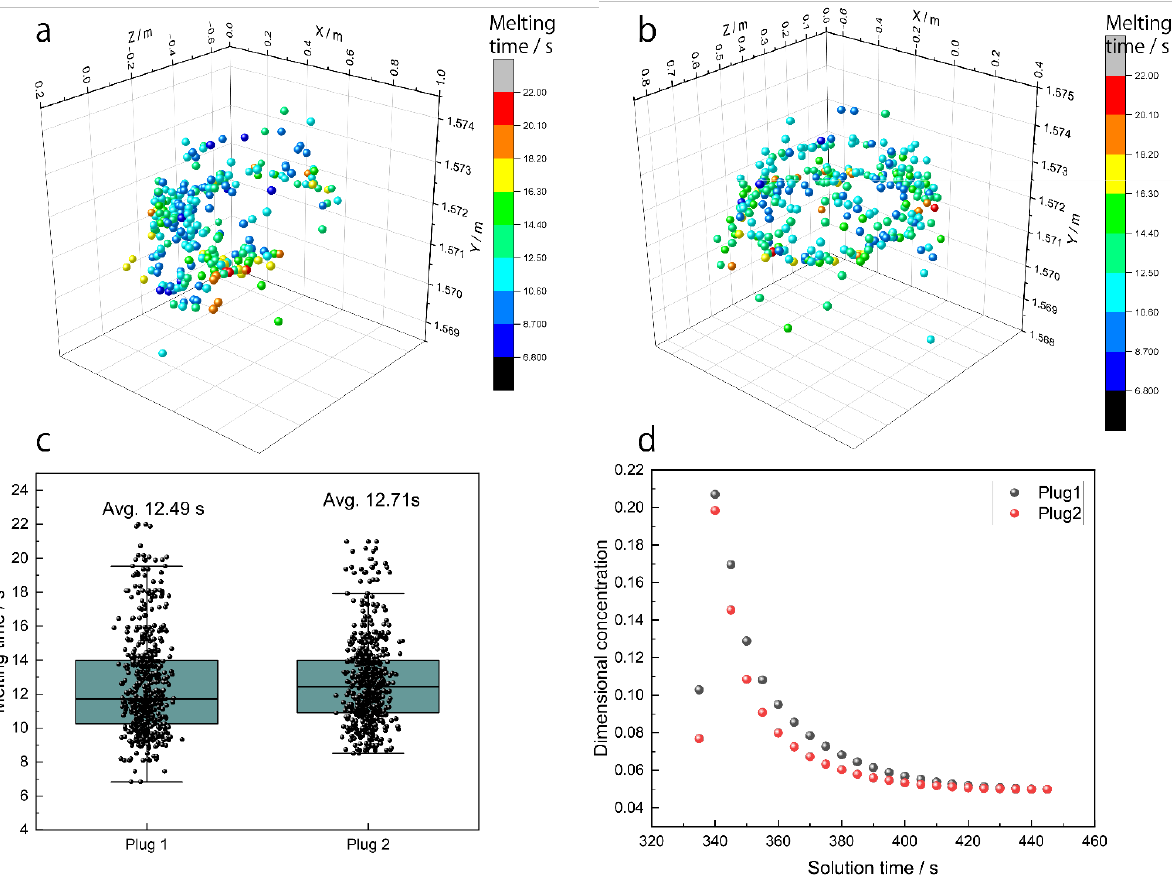
Figure 15. The alloy melting position when the alloy is adde d on the ‘slag eye’ above ( a ) plug 1 and ( b ) plug 2; ( c ) the alloy melting time and ( d ) the average dimensional concentration under different alloy add-in positions.